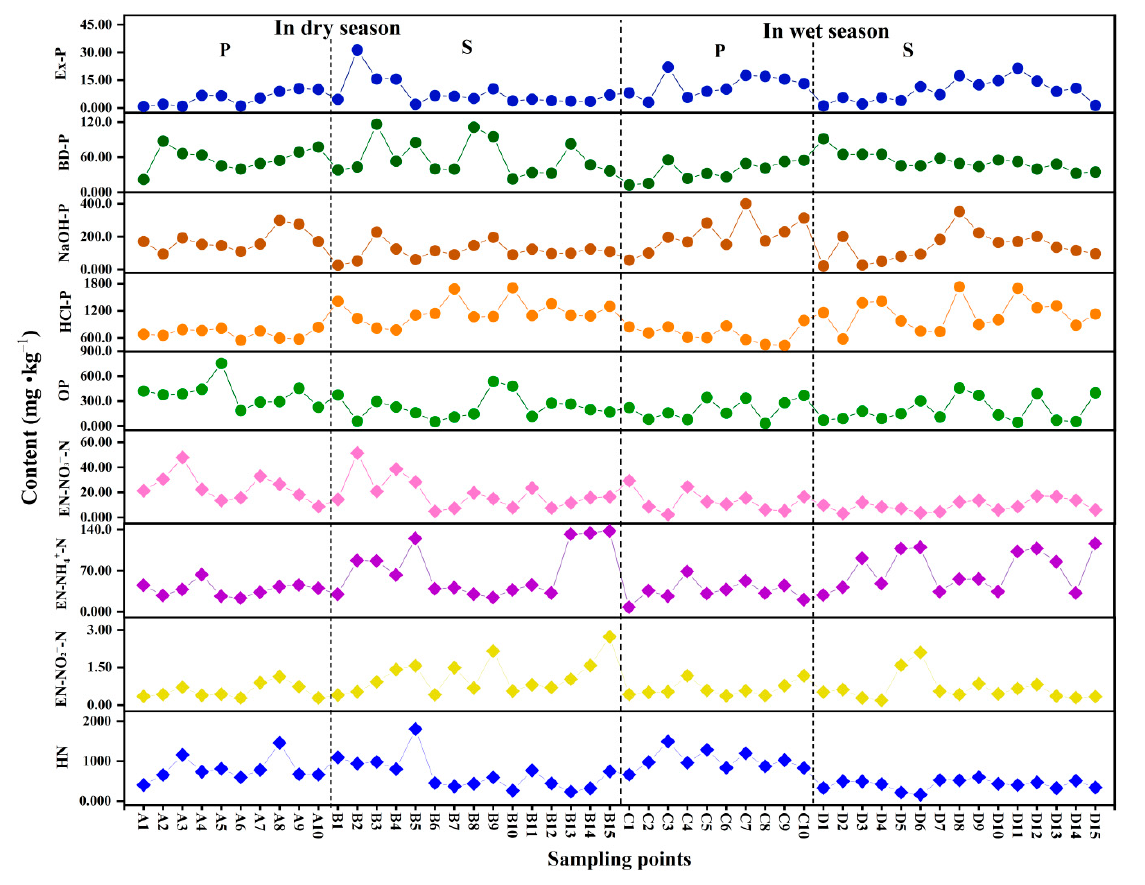
Figure 8. N and P fraction content distribution in surface sediments in the study area (P: Pi river, S: Shiting river).